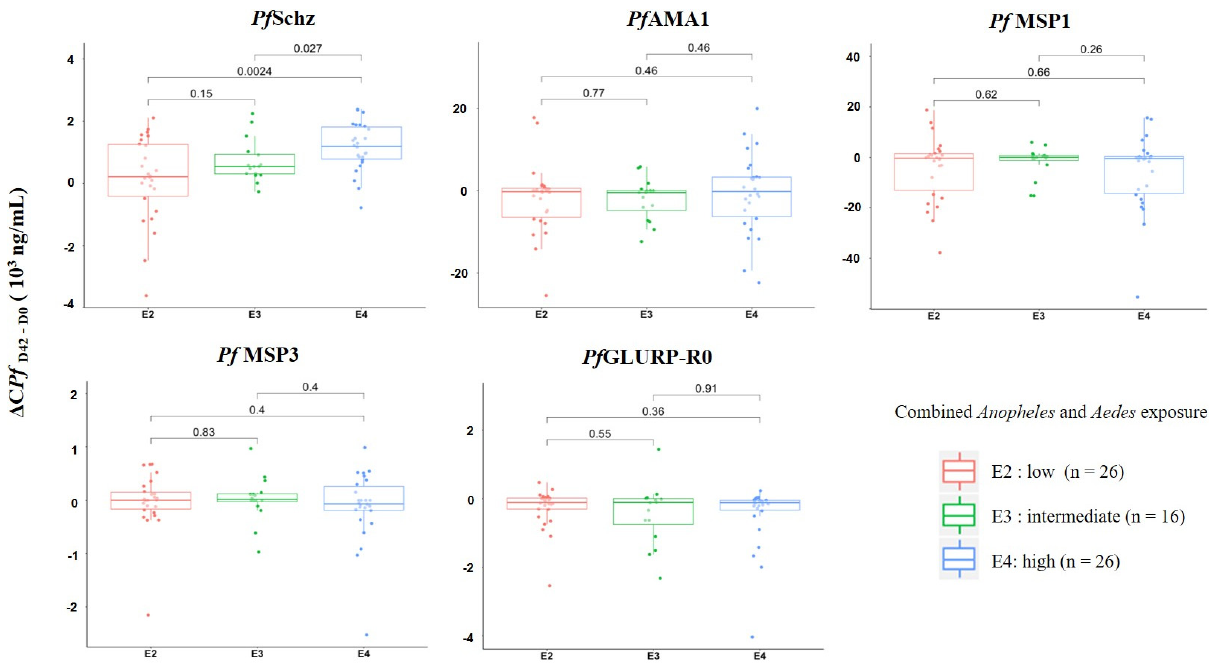
9 of 18 Figure 1. Variation in concentration of IgG response to P. falciparum antigens according to group of exposure to Anopheles and to Aedes (single-genus exposure). Participants were grouped according to their level of IgG response to Anopheles (lower exposure (LEAno) < Δ ODgSG6-P1 = 1.41 < higher -exposure (HEAno)) and to Aedes (lower exposure (LEAe) < Δ ODNterm-34 kDa = 1.10 < higher ex- posure (HEAe)) salivary peptide. Each dot represents an individual, and box plots indicate the me- dian values, 25th and 75th percentile antibody concentration for each P. falciparum blood-stage an- tigen. Statistically significant difference in median value between the two groups is indicated (Mann–Whitney U test). Individuals who had a higher exposure to Anopheles (HE Ano ) or to Aedes (HE Ae ) bites exhibited a greater increase in anti- Pf Schz IgG levels than those with a lower exposure ( p = 0.0029 for Anopheles and p = 0.005 for Aedes ). No significant differences in the variation of IgG responses to merozoite antigens were noted between the two groups exposed to Anopheles or Aedes bites. Second, we compared the dynamics of anti- Plasmodium immune responses according to the level of combined exposure to both Anopheles and Aedes bites (E2 = low, E3 = inter- mediate, E4 = high; Figure 2). We observed a positive association between the increase in the IgG response to Pf Schz and the level of mosquito exposure during the follow-up. In-